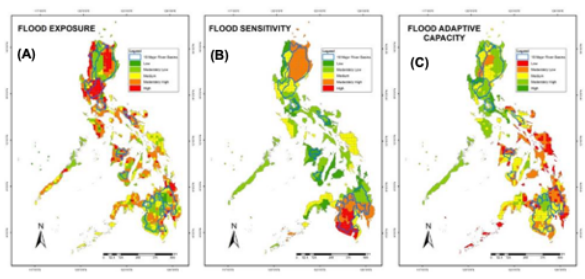
Figure 5. Cagayan Valley RB maps of (A) flood hazard from DREAM Project, (B) flood exposure, and (C) flood vulnerability. The flood hazard map is derived from modeled 5-year return hazard, and 3 – high hazard.